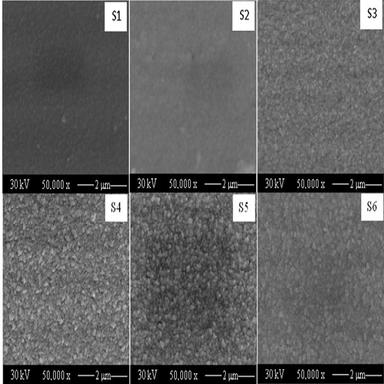
he FESEM images of Bi2Te3 samples.